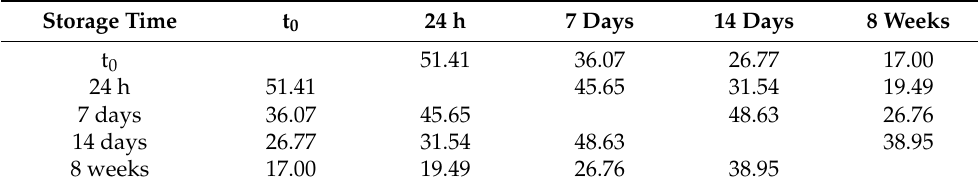
Table 5. f2 comparison. Kinetic hydrogen generation measurements were compared with the f2 comparison; according to SUPAC guidelines release profiles of tablets with a f2 value between 50 and 100 are considered similar.